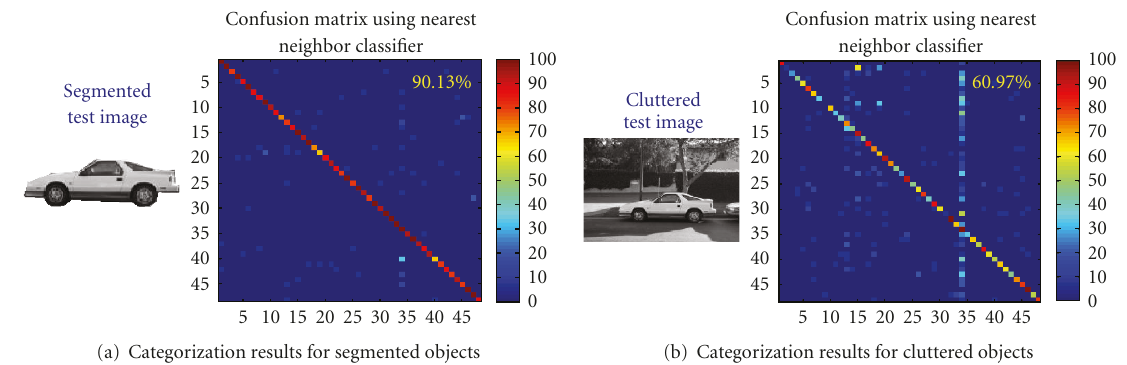
Figure 3: The e ff ect of background clutter to object categorization using the bag of visual words. Confusion matrix measure is used for